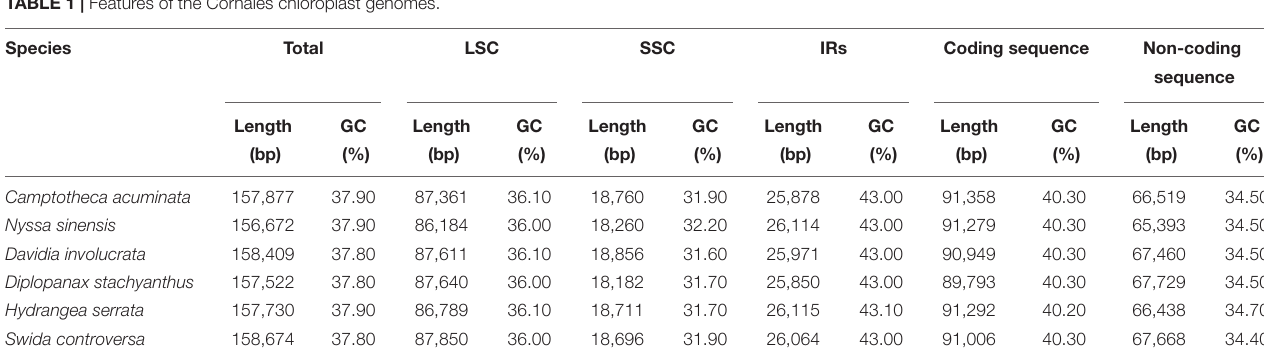
TABLE 1 | Features of the Cornales chloroplast